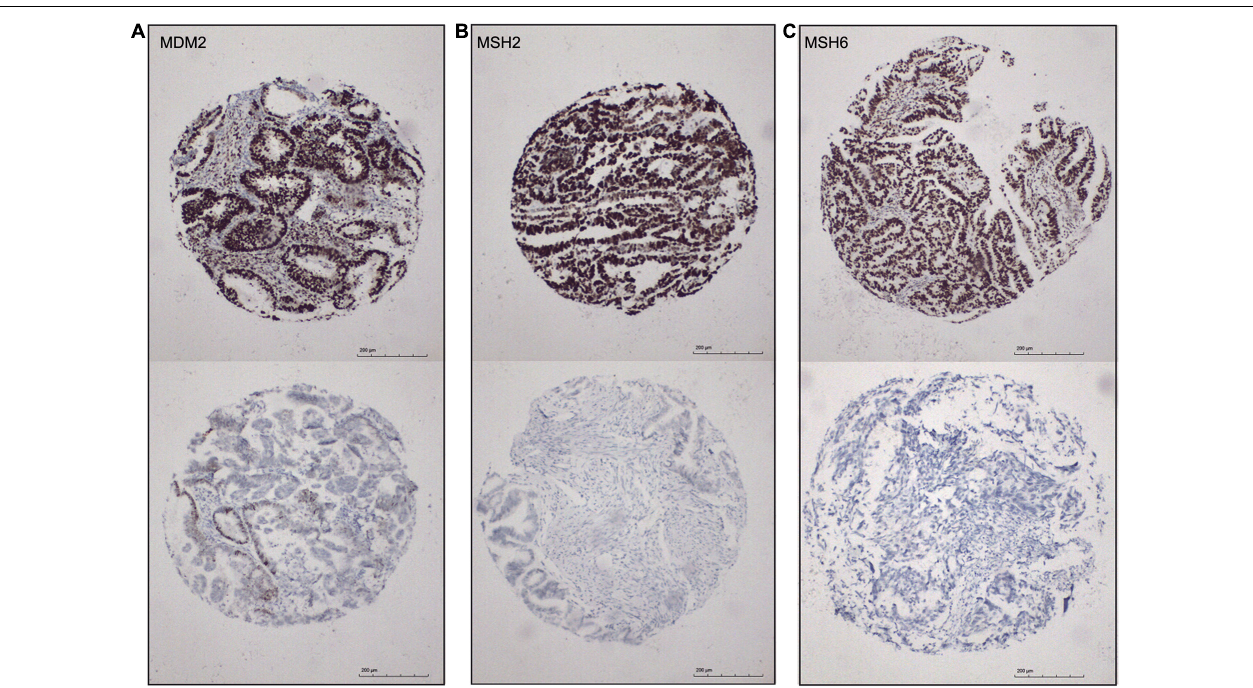
FIGURE 6 | Immunohistochemical markers for subtype I and subtype II ECA. (A–C) Representative staining for MDM2, MSH2, and MSH6, respectively (positive, score 3; negative, score 0), 100 × .